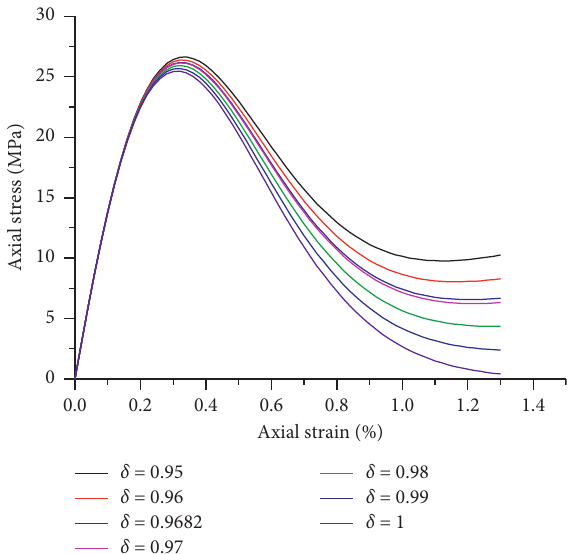
Figure 9: Influence of the damage coefficient on the stress-strain